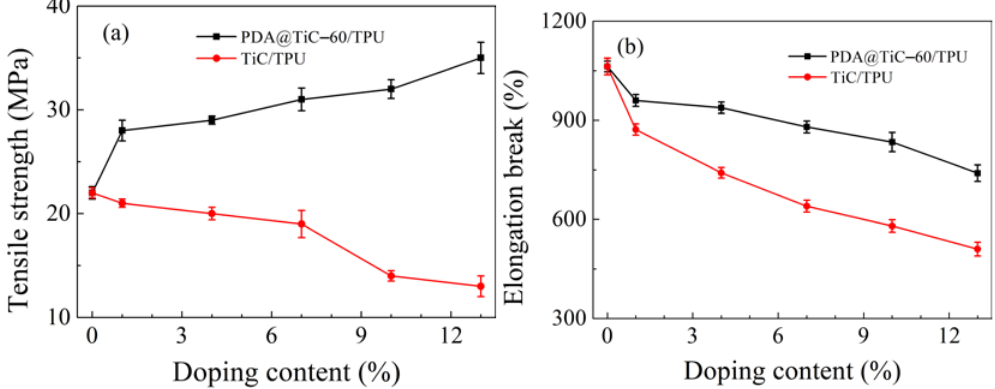
Figure 9. Effect of TiC and PDA@TiC − 60 loading amount in TiC/TPU and PDA@TiC − 60/TPU on Figure 9. E ff ect of TiC and PDA@TiC − 60 loading amount in TiC / TPU and PDA@TiC − 60 / TPU on tensile tensile strength ( a ) and strain ( b ), respectively. strength ( a ) and strain ( b ),